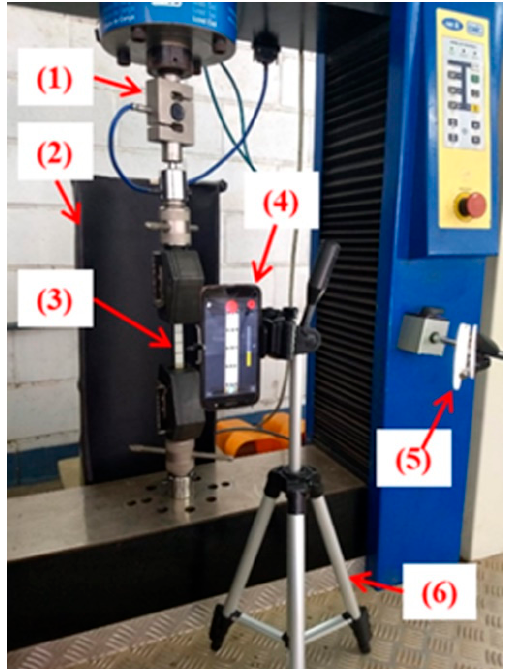
Figure 2. Tensile test set-up. ( 1 ) Load cell of 20 kN; ( 2 ) black cardboard to make a contrast in the background of the specimens; ( 3 ) tensile specimen; ( 4 ) digital camera of 13 MegaPixel; ( 5 ) lighting and ( 6 ) pedestal.